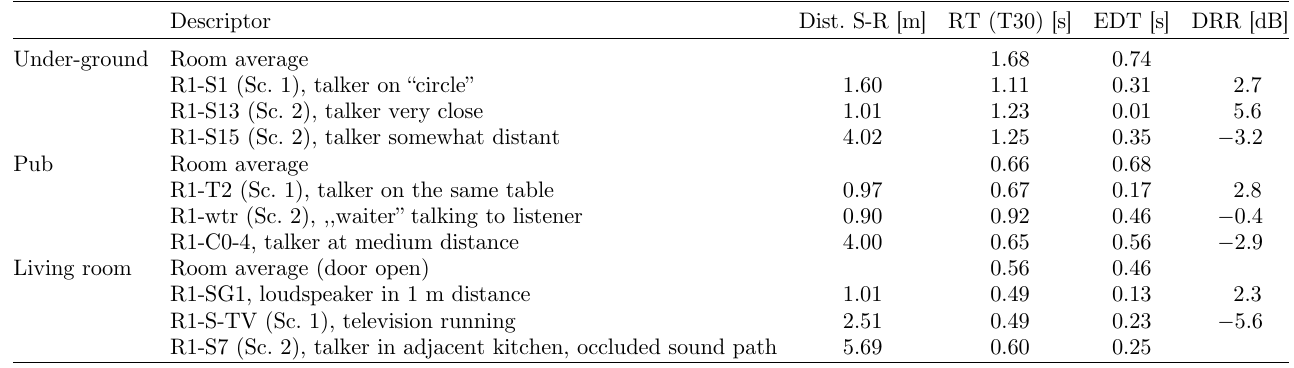
Table 1. Various acoustic parameters for a comparable set of source-receiver combinations de fi ned and measured within the three environments. In addition, room averages are calculated from a number of omnidirectional microphones and omnidirectional sources (except for the Pub, where all loudspeakers were used). Shown are the distance between source and receiver (occluded path length for the source in the adjacent kitchen of the Living room), the reverberation time, the EDT, and the DRR, in columns 3 to 6, respectively.